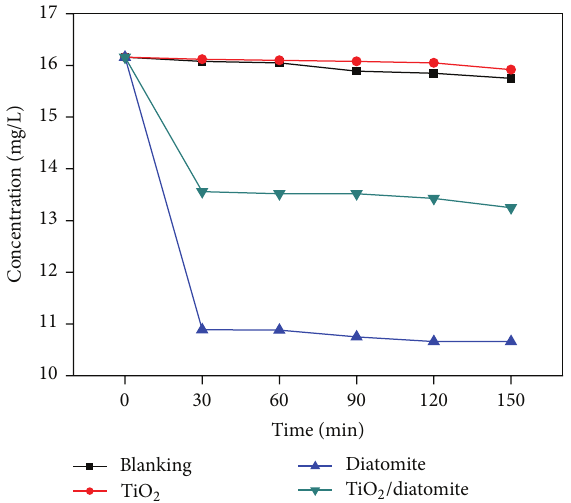
Figure 4: Removal of MB by different sorbents due to adsorption.